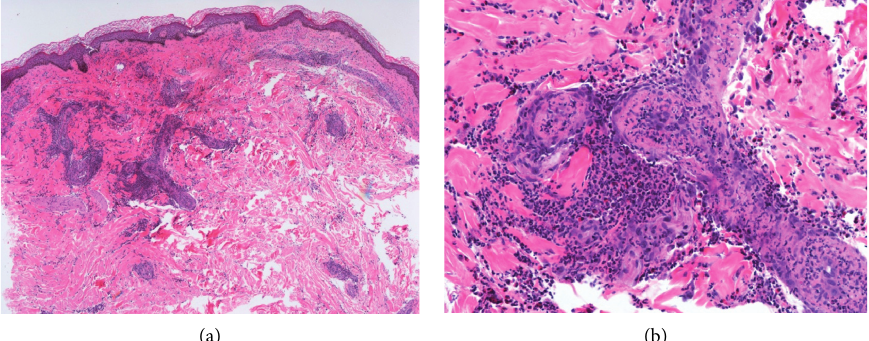
Figure 3: Histopathologic findings of the cutaneous lesions depicting leukocytoclasic vasculitis consistent with granulomatosis with polyangiitis. (a) Superficial and deep dermal perivascular inflammation with thrombus formation (H&E stain, 10x). (b) Extravasated erythrocytes and leukocytoclasia seen in the dermis with fibrinoid necrosis of vessels (H&E stain, 40x) and perivascular infiltrate composed of lymphocytes, histiocytes, neutrophils, and eosinophils.